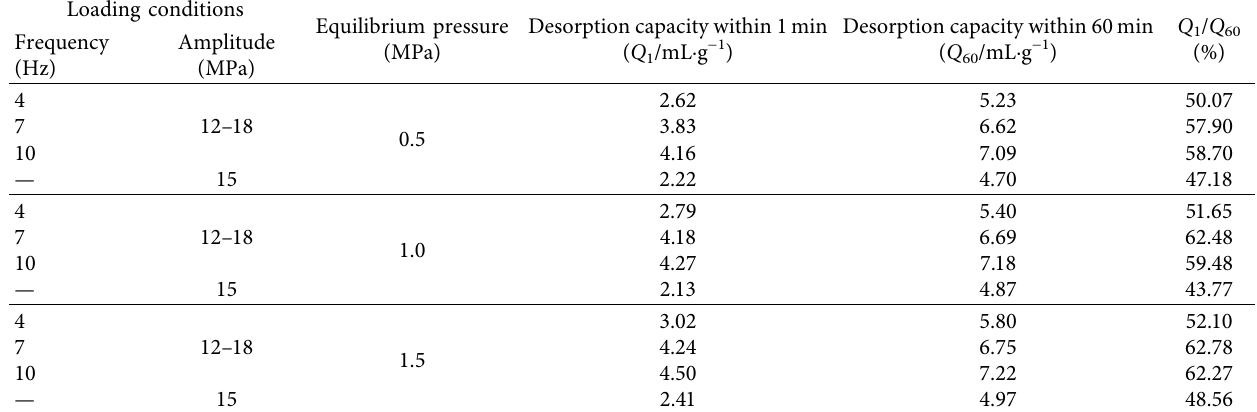
Table 3: Cumulative desorption capacity from the briquettes under different loading frequencies. Loading